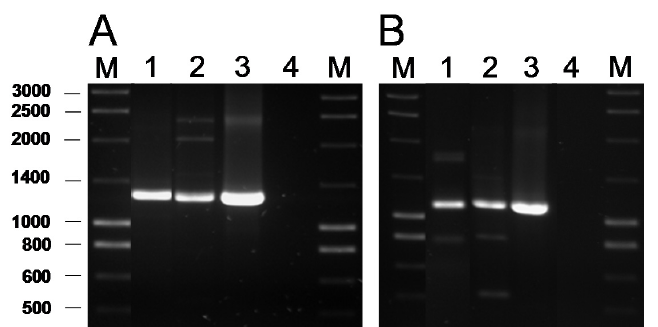
Figure 1. PCR amplification of tetracycline resistance genes using the universal primers Tet1 and Tet2 targeting a segment of 1,300 bp of the genes encoding RPP ( A ) and 1,200 bp of the tet (W) gene